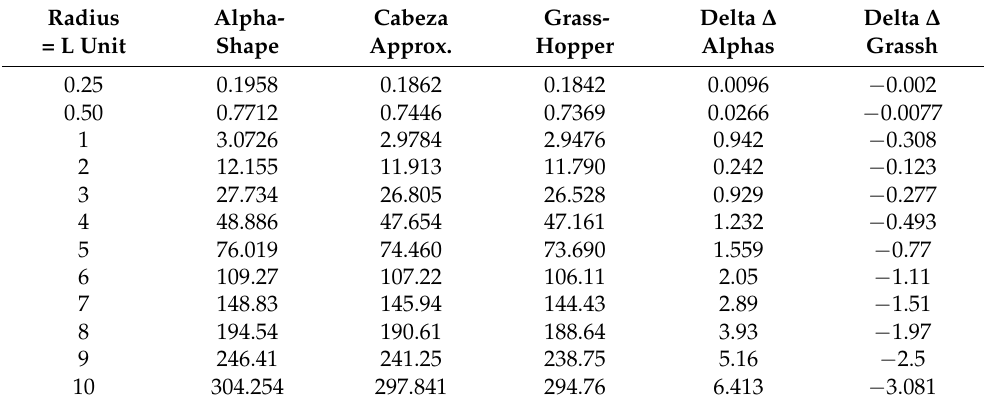
Table 1. Results of computing the area of several conoids by the method proposed by the author and with graphic interpolation procedures allowed by the software Grasshopper and the command Alphashape of Matlab. Radius Alpha- Cabeza Grass- Delta ∆ Delta ∆ = L Unit Shape Approx. Hopper Alphas Grassh 0.25